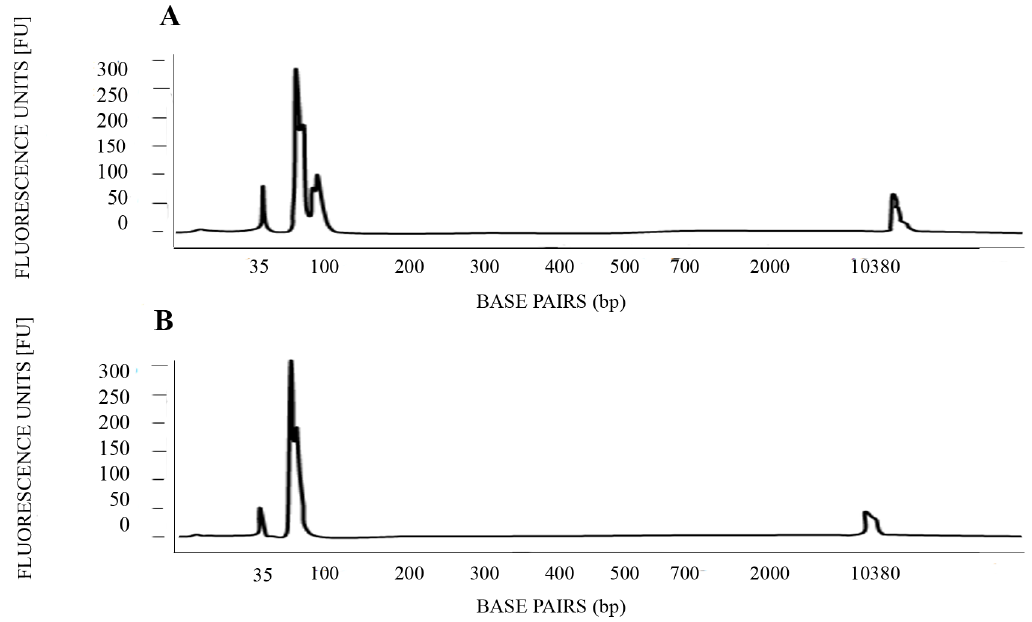
Figure 3. Confirmation of the HRM analysis by a Bioanalyzer assay. AMELX-allele and AMELY-allele fragment (61 and 64 bp, respectively) of positive controls were amplified by real-time PCR and then analyzed by the Agilent 2100 Bioanalyzer Expert High Sensitivity DNA Assay . The results show a differential pattern in terms of amplicons length. ( A ) Male positive control. ( B ) Female positive control.